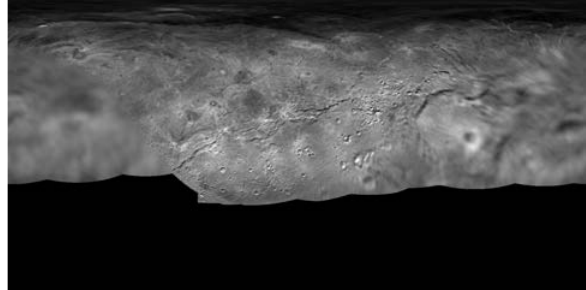
Figure 1b. Global panchromatic mosaic of Charon at 400 m/pixel. Map centered on 0° longitude. Dark areas were unilluminated during the 2015 encounter. Notes as in Figure 1a.